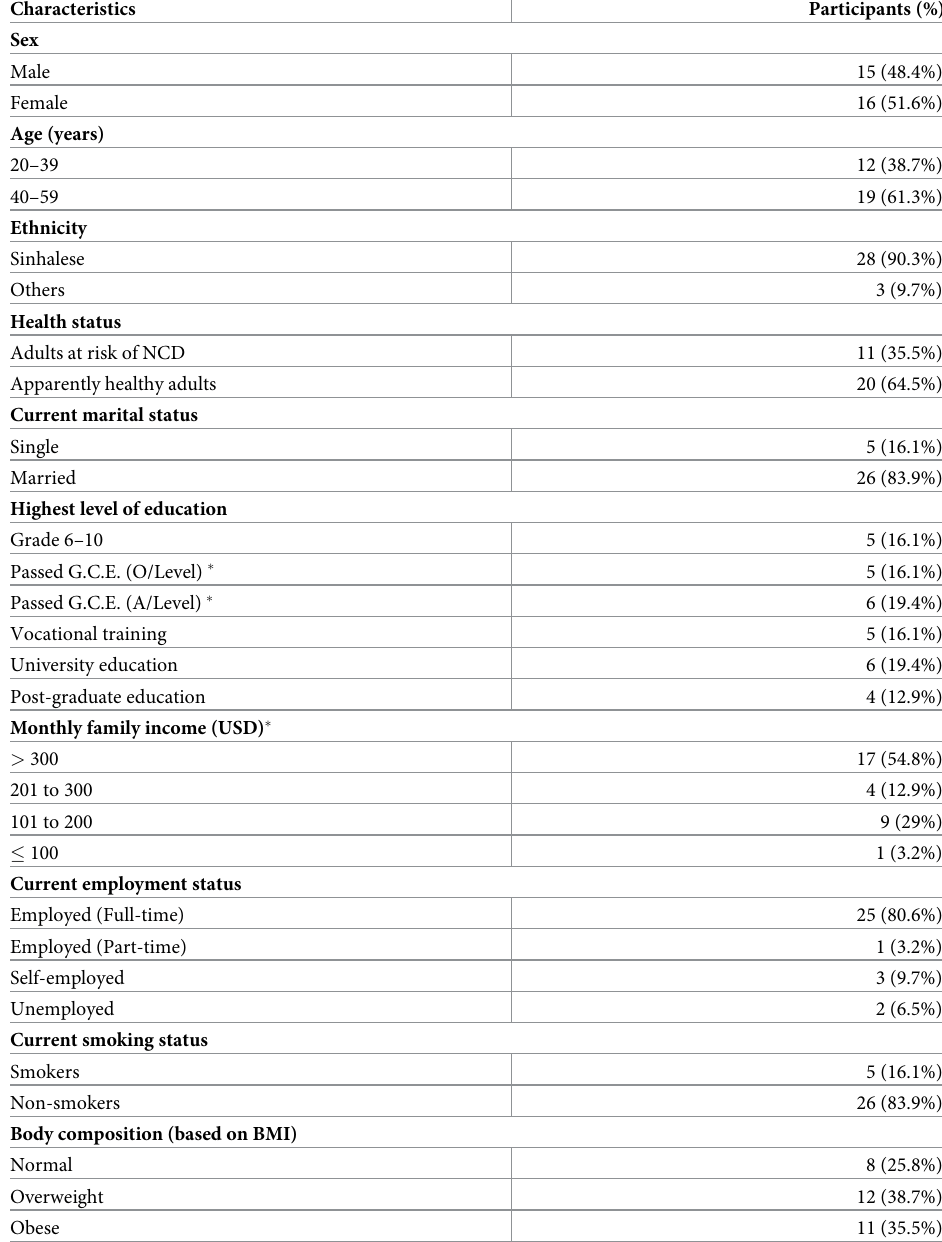
Table 1. Socio-demographic and anthropometric characteristics of the participants.